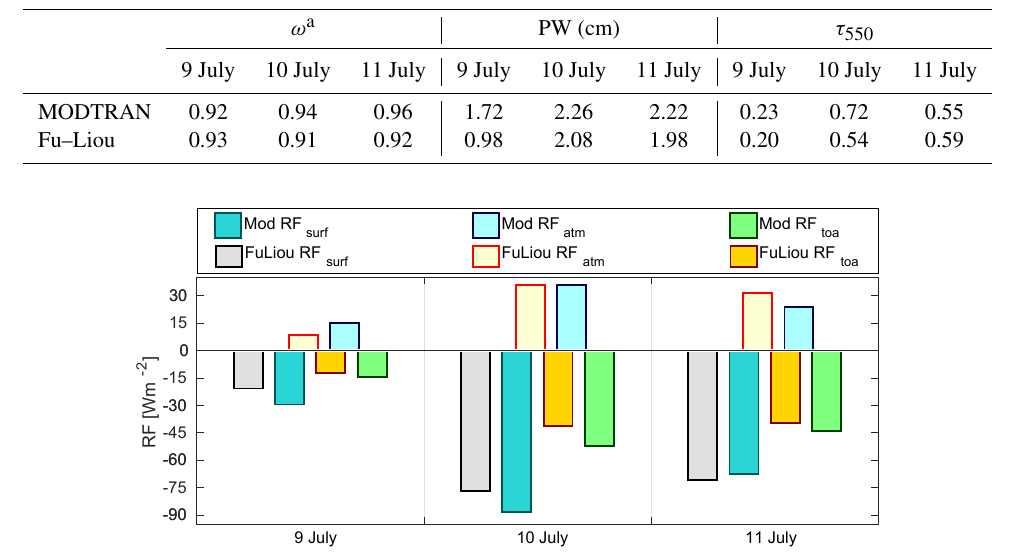
Figure 5. The mean daily values of radiative forcing (RF) calculated by means of Fu–Liou (FuLiou) and MODTRAN (Mod) models. Simulations were run for clear-sky conditions at the surface (subscript “surf”), within the atmosphere (subscript “atm”), and at the top of the atmosphere (subscript “toa”). The surface reflectance in MODTRAN simulations is based on the Fresnel reflection calculations at the ocean